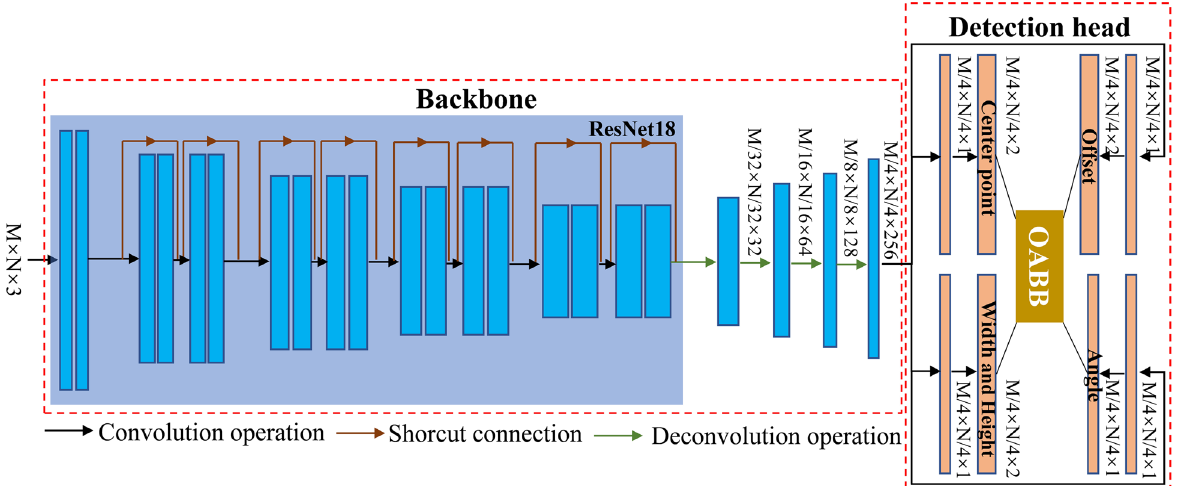
Fig. 2 Detailed architecture of the anchor-free equipment OABB